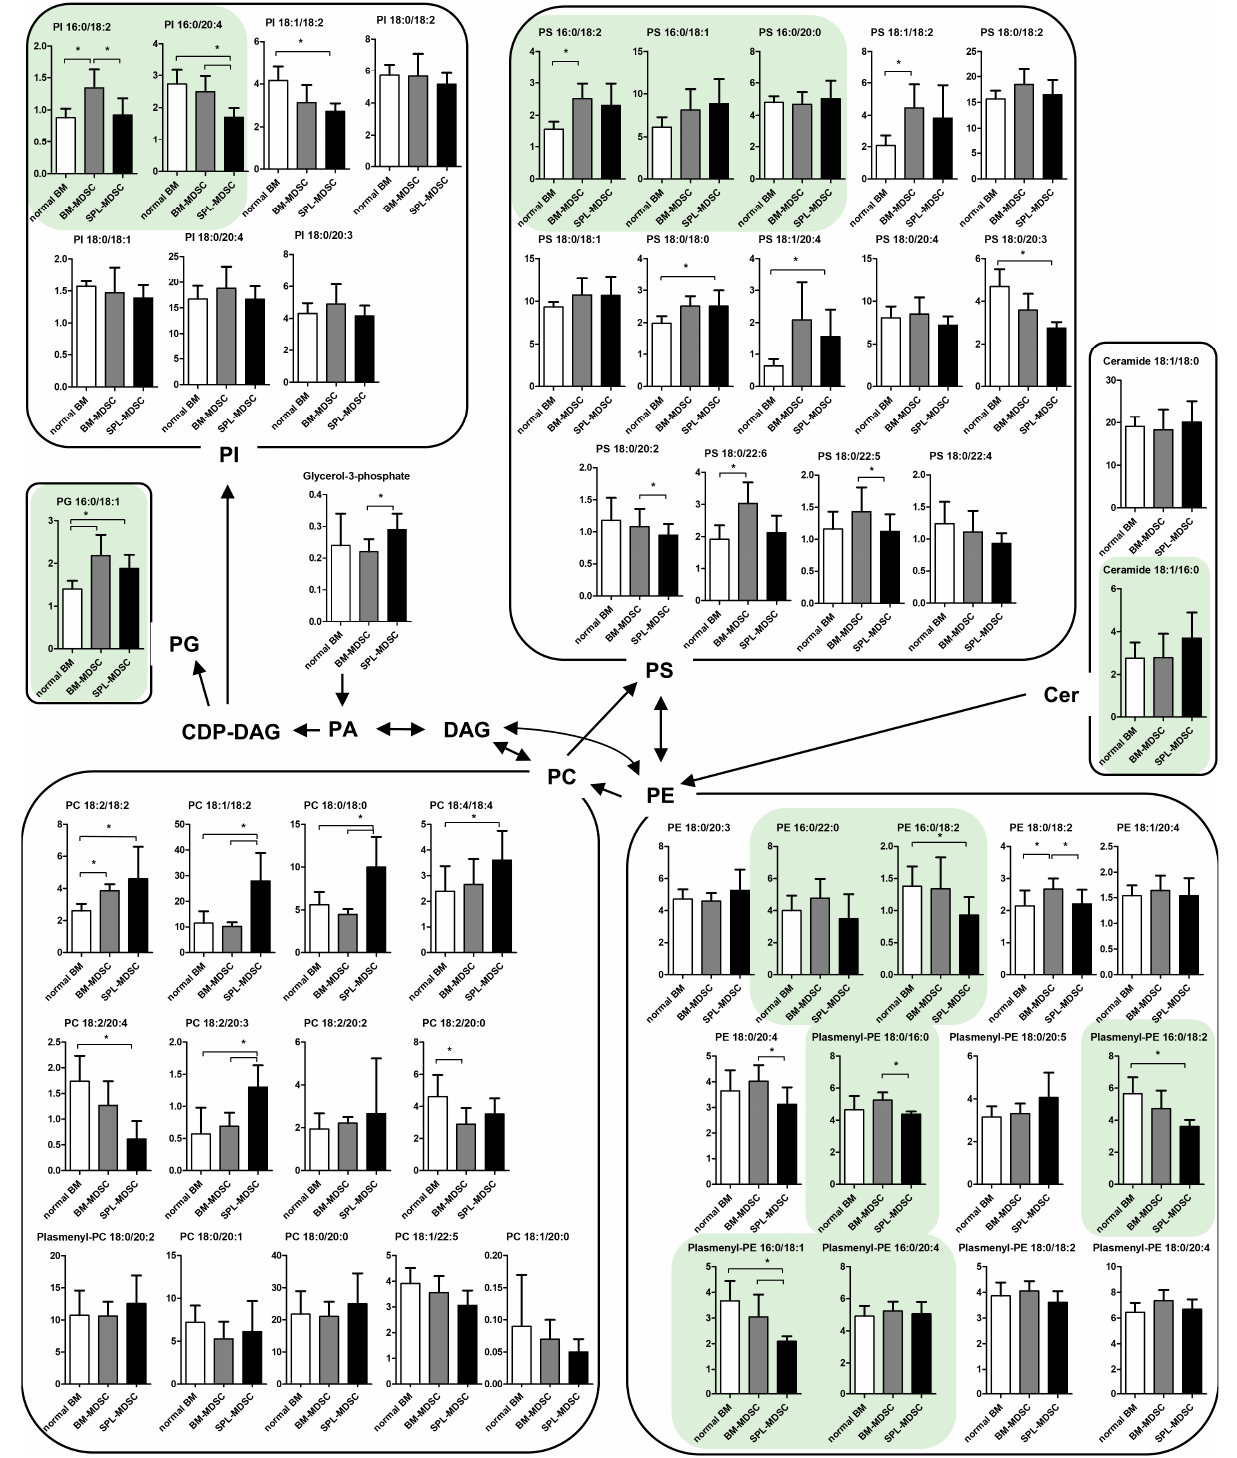
Figure 2. Comparative lipidomic profiles in BM cells and MDSCs. The proposed metabolic pathway is presented based on data in the KEGG database (http://www.genome.jp/kegg/, accessed on 4 November 2022). Each value represents the mean ± standard deviation (SD) ( n = 6, three biological and two experimental replicates). *, p < 0.05. Green boxes indicate lipids containing palmitic acid (C16). The p values were obtained by a Mann – Whitney U test.